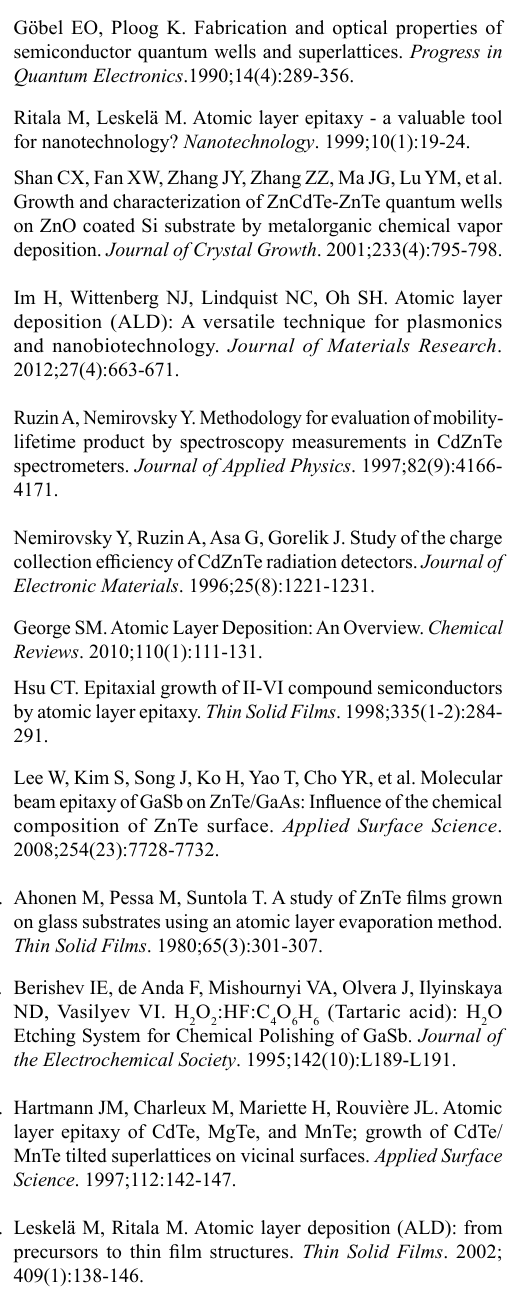
Figure 7. The peaks at 274 to 290 cm -1 are composed by the TO-GaAs and LO-GaAs vibrational modes, originated from the GaAs substrate, because of the penetration depth of laser light is larger than the ZnTe layer thickness and reaches the substrate, so the Raman spectra exhibit peaks related to the substrate characteristics. The peak near 231 cm -1 is the corresponding to the GaSb substrate and is composed of the TO-GaSb and LO-GaSb in 238 cm -1 . In addition, the peak corresponding to LO-ZnTe shows weakness and a slightly displacement in comparison with the reported for the bulk ZnTe at 210 cm -1 19-26 , possibly due to the layers stress and the nanometric thickness of these layers, as has been reported by other authors 21 .